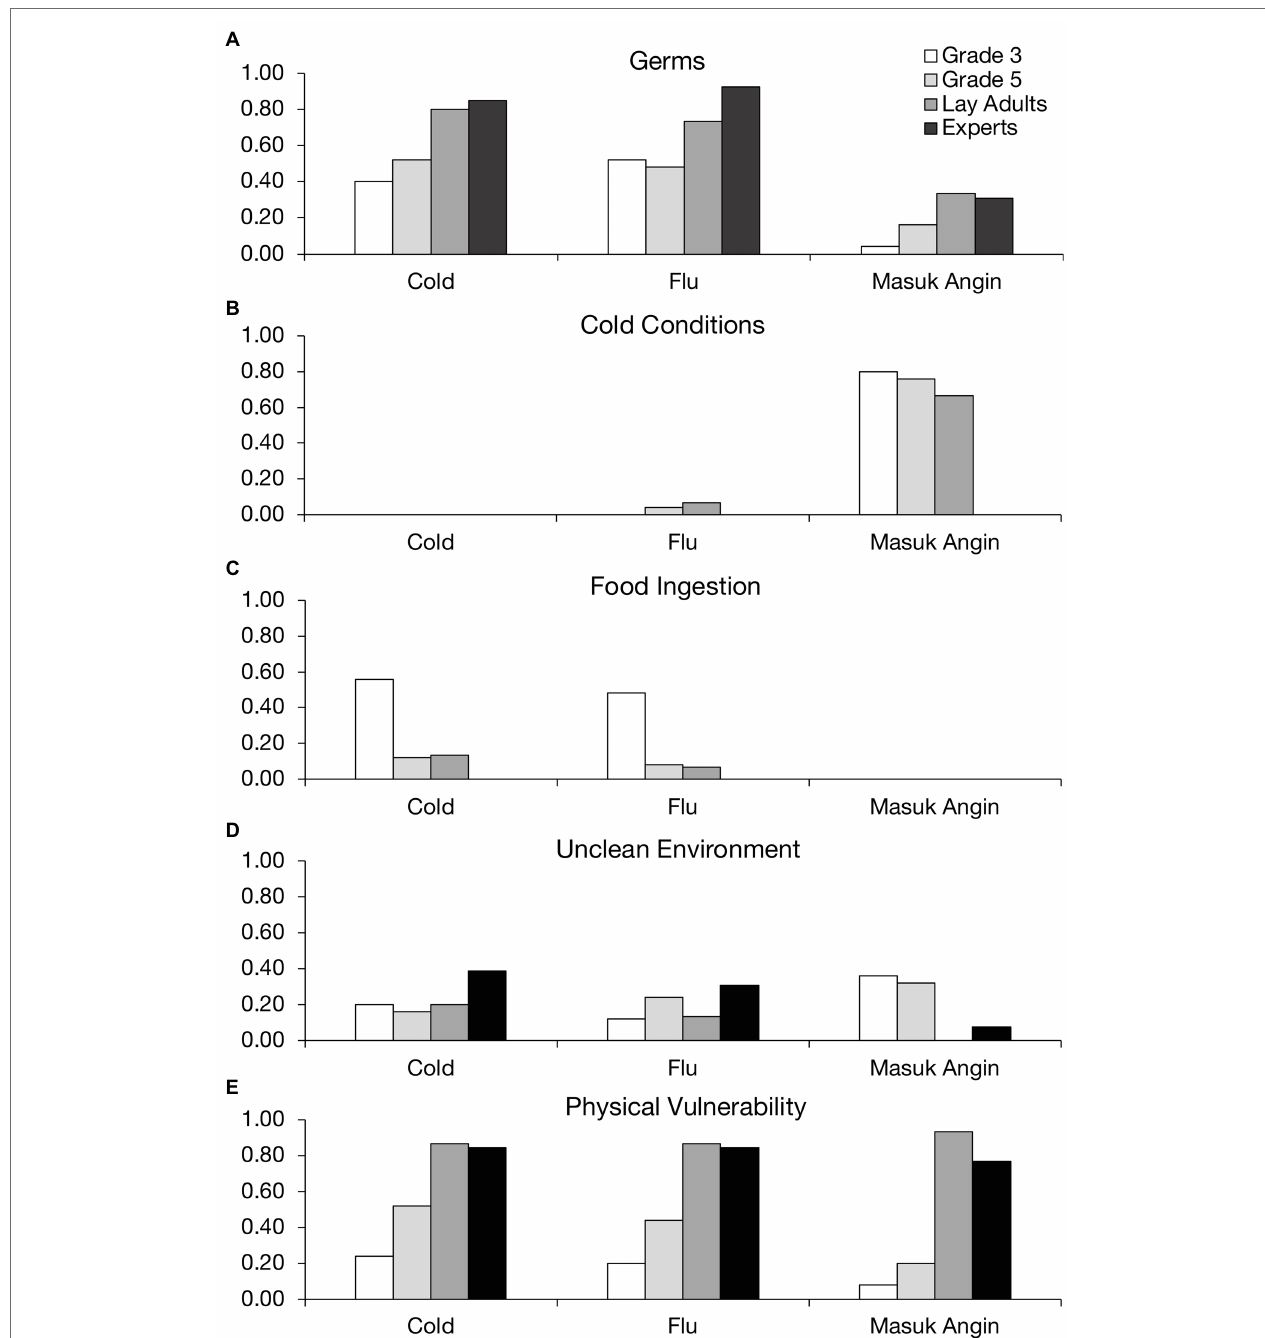
FIGURE 1 | Proportion of participants who mentioned a given cause for each